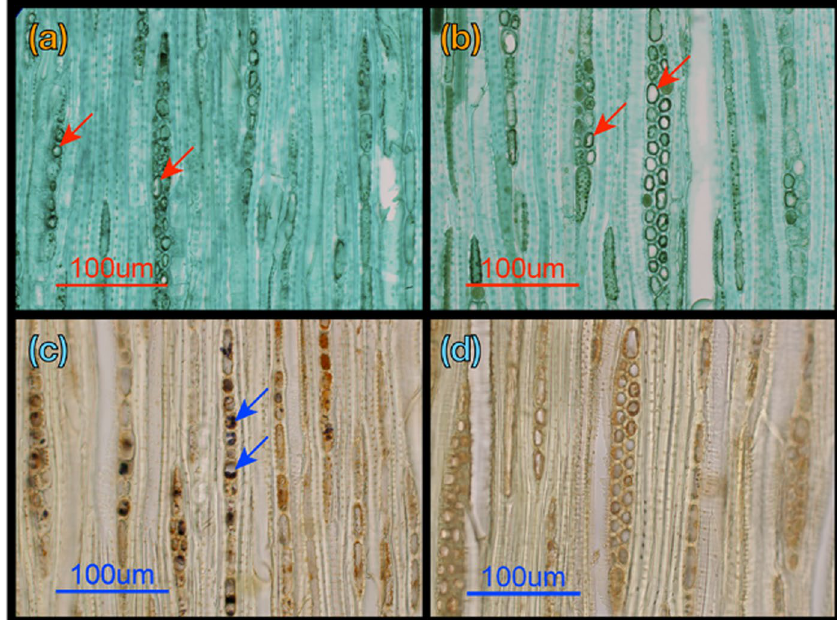
Figure 4. Sections tangential to the tree ring stained with Fast Green, which has a high cellar cytoplasm affinity, and with iodine–potassium iodine (I–KI) solution, which stains starch granules in the sapwood of branchlets. ( a ) Section from the healthiest tree stained with Fast Green. ( b ) Section from the least healthy living tree stained with Fast Green. ( c ) Section from the healthiest tree stained with I–KI solution. ( d ) Section from the least healthy living tree stained with I–KI solution. In panels (a) and (b) red arrows show the cells counted as damaged cells. In panel (c) blue arrows show starch granules in the cells. The length of the scale bars is 100 µ